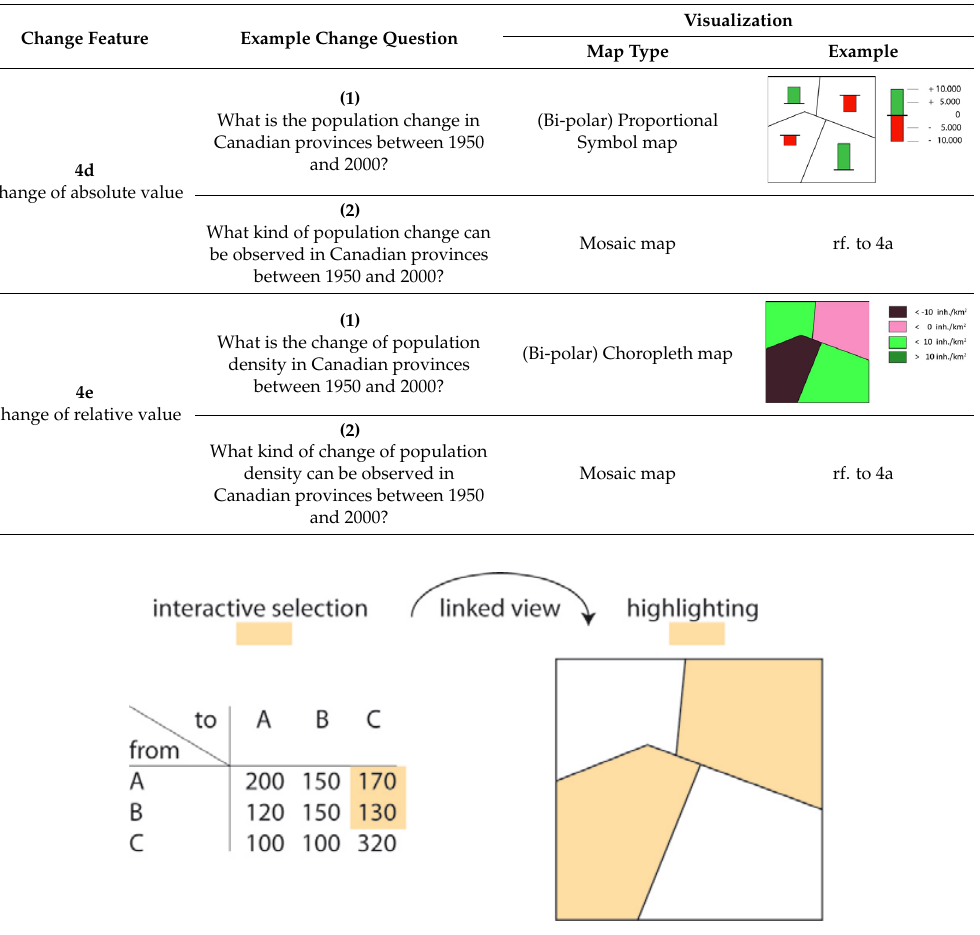
Figure 1. Linked view between change matrix and binary mosaic map for depicting various combinations of class changes (related task: “Is there any change from any class to class C in Canadian provinces between 1900 and 2000?”).